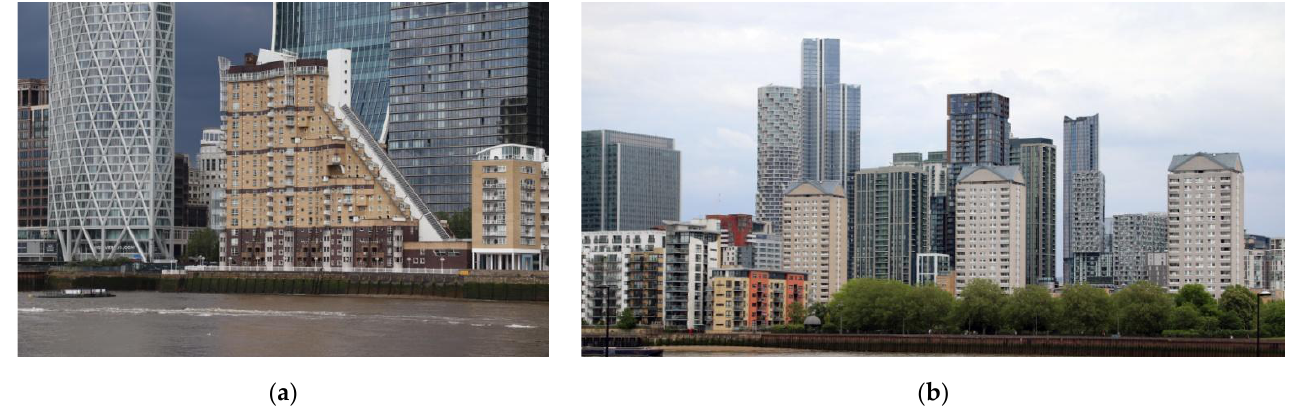
Figure 6. Residential towers from C20: ( a ) The Cascades (2021); ( b ) Towers of Barkantine Estate at the foreground (2021).